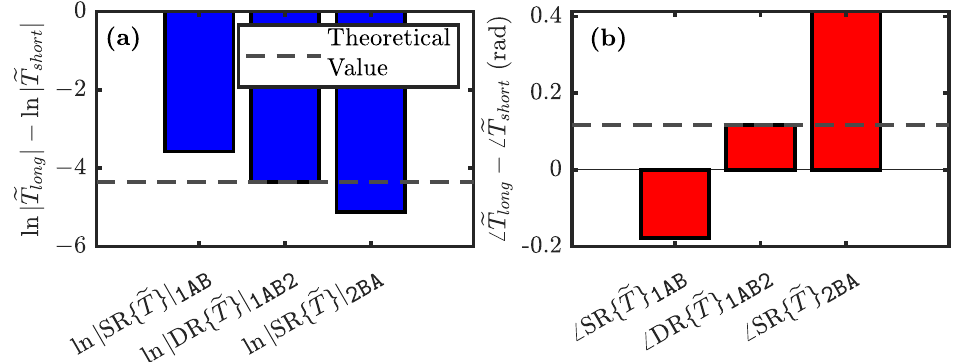
Figure 4. Demonstration of the cancellation of coupling factors when considering the ln | DR { (cid:101) T }| and ∠ DR { (cid:101) T } measurements. For this simulation, random (cid:101) C s were generated for each optode and Equations (33)–(36) implemented. All other simulation parameters are the same as Figures 1 and 2. The expected theoretical value for the measured differences is shown as a dashed line. ( a ) The two symmetric ln | SR { (cid:101) T }| measurements and the ln | DR { (cid:101) T }| measurement. ( b ) The two symmetric ∠ SR { (cid:101) T } measurements and the ∠ DR { (cid:101) T } measurement. Acronyms and Symbols: Green’s function for the complex Transmittance ( (cid:101) T ), Single-Ratio of the (cid:101) T (SR { (cid:101) T } ), SR { (cid:101) T } amplitude ( | SR { (cid:101) T }| ), natural logarithm of | SR { (cid:101) T }| (ln | SR { (cid:101) T }| ), SR { (cid:101) T } phase ( ∠ SR { (cid:101) T } ), Dual-Ratio of the (cid:101) T (DR { (cid:101) T } ), DR { (cid:101) T } amplitude ( | DR { (cid:101) T }| ), natural logarithm of | DR { (cid:101) T }| (ln | DR { (cid:101) T }| ), DR { (cid:101) T } phase ( ∠ DR { (cid:101) T } ), and complex optical Coupling, power, and/or efficiency factor ( (cid:101) C